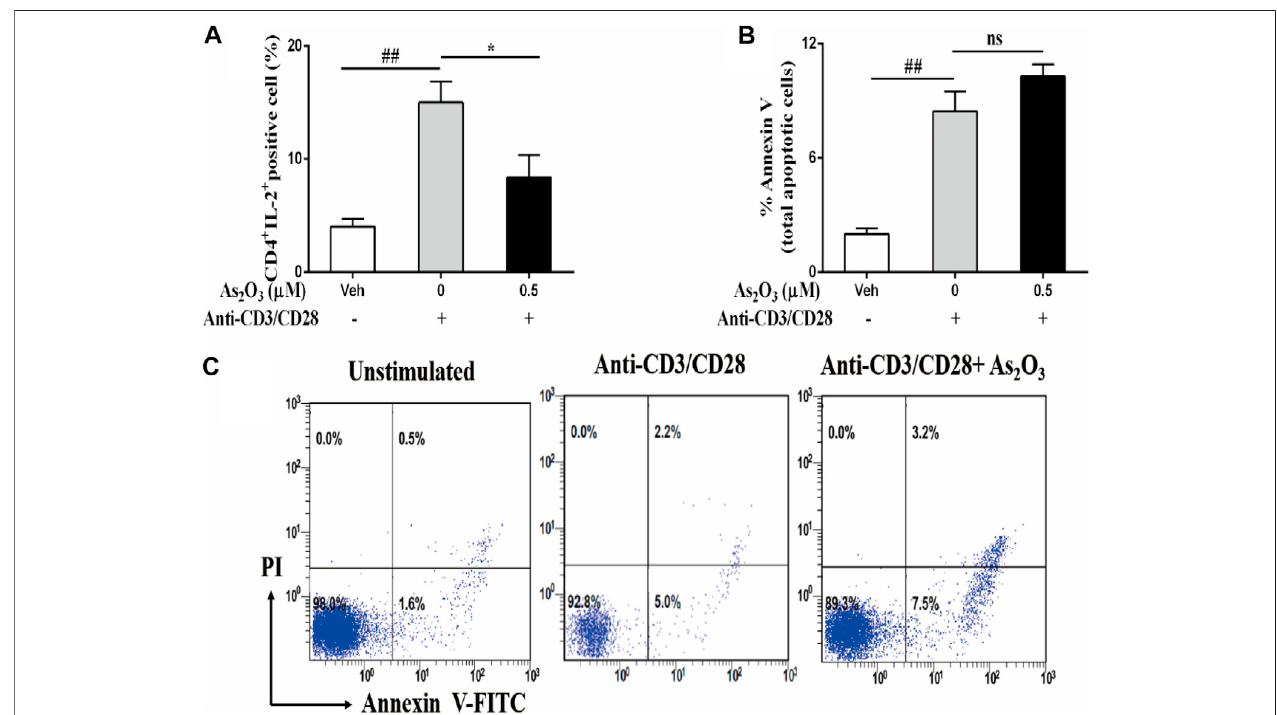
FIGURE2| As 2 O 3 suppressIL-2expressionfromactivatedCD4 + Tcellswithoutaffectingtheirviability.PBMCs(1 × 10 6 cellsperwell)wereleftuntreatedortreated withAs 2 O 3 (0.5 µM)for30 min. Cells werethen stimulated withanti-CD3/CD28 for 8 h. Subsequently, cells werestained onthesurface and intracellularly,and analyzed by fl ow cytometry. (A) Percentage of intracellular production of IL-2 from CD4 + T cell is shown as means ± SEM of six independent experiments. (B,C) Cell apoptosis